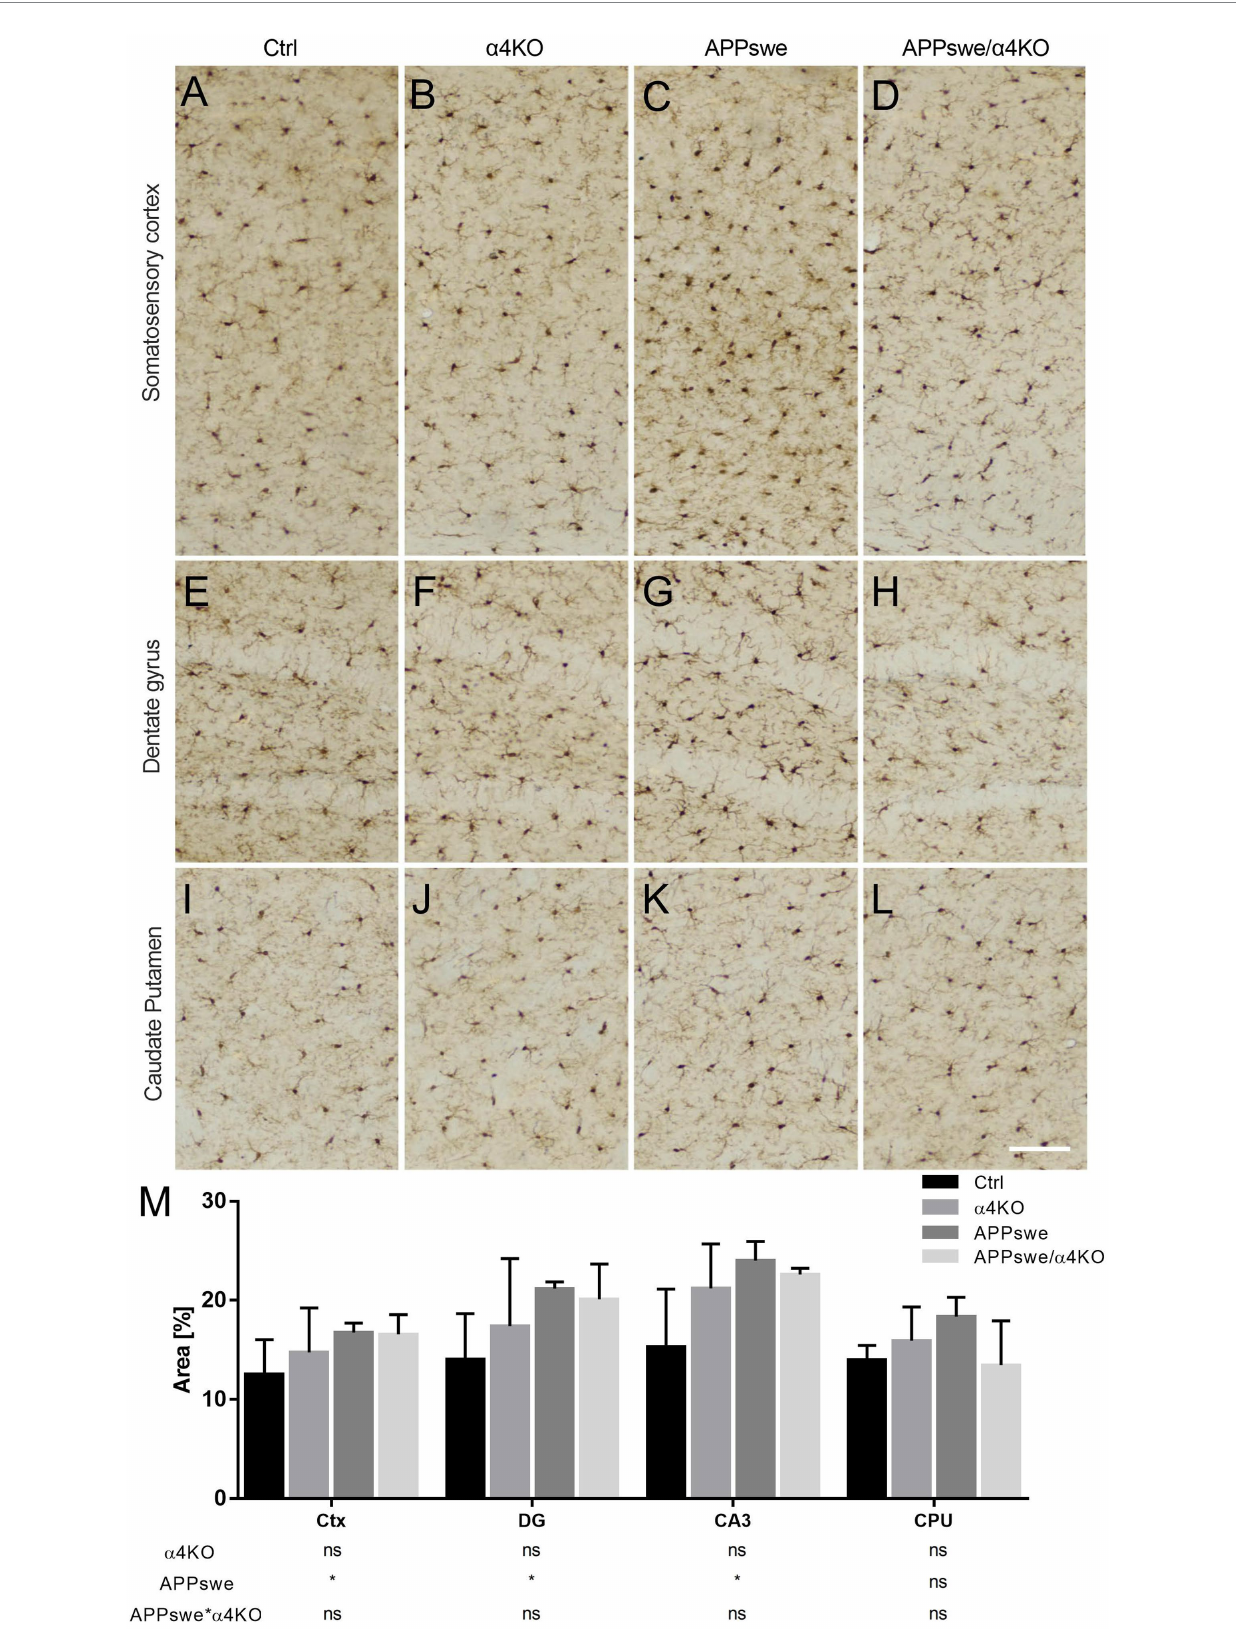
FIGURE 7 Quantitative analysis of Iba1 immunoreactivity in 15 mo mice. (A–L) Representative images of Iba1+ staining through the sCtx (A–D) , hippocampal DG (E–H) and CPU (I–L) of Ctrl (A,E,I) , α 4KO (B,F,J) , APPswe (C,G,K) , and APPswe/ α 4KO (D,H,L) 15 mo mice. Scale bar = 100 μ m. (M) Quantitative analysis related to % area coved by Iba1+ ir in sCtx, DG and CA3 field of hippocampus, and CPU Data are shown as mean ± SEM and compared by two-way ANOVA test, * p < 0.05. Ctx, cerebral cortex; DG, dentate gyrus; CA3, Cornu Ammonis 3 of hippocampus; CPU, caudate